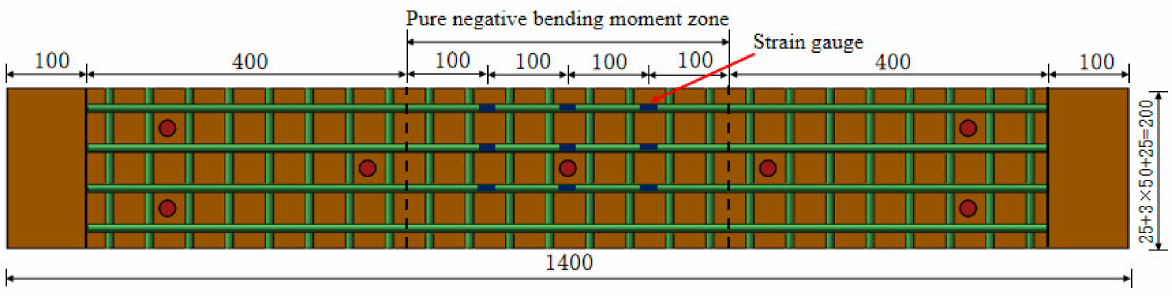
Figure 8. Vertical section and horizontal cross-section of specimen Z/DS45-4 (Dimensions in mm).